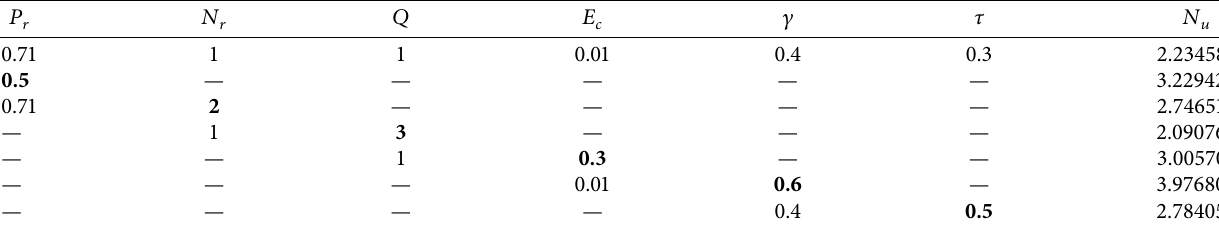
u under various physical